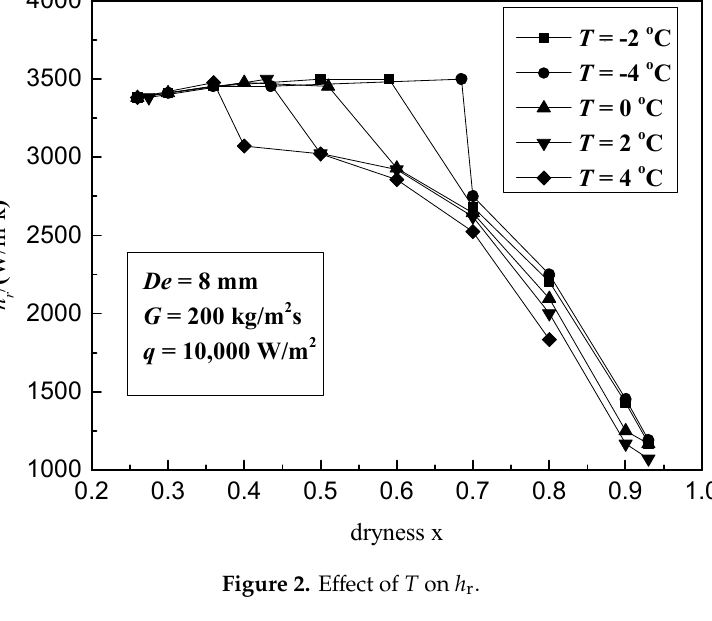
Figure 2. Effect of T on h r. Figure 2. E ff ect of T on h r .